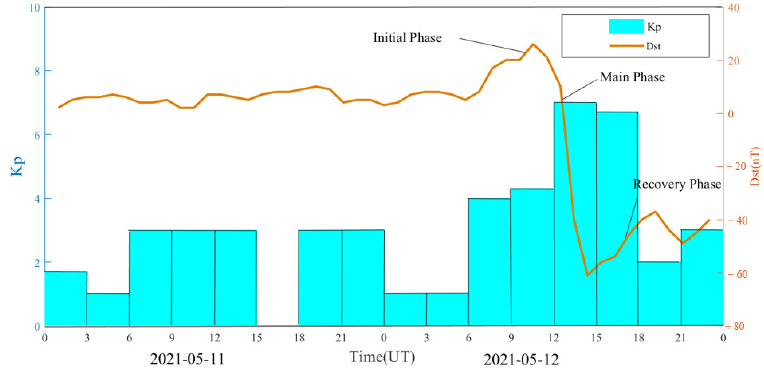
Figure 1. Kp and Dst indices from 11 to 12 May